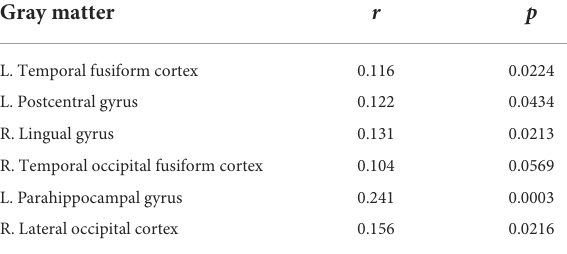
TABLE 3 Summary results of Mantel tests showing r and p values of the matrix correlation between gray matter and β -diversity metrics. Gray